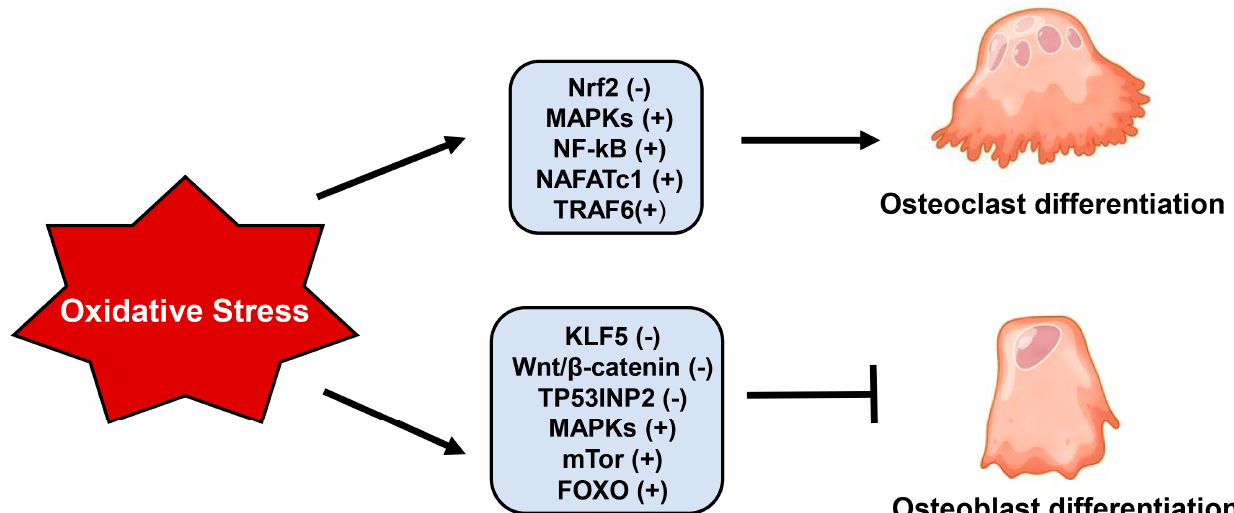
Figure 1. Principal molecular factors involved in the role of oxidative stress on osteoclastic and osteoblastic differentiation. Abbreviations: Nrf2, nuclear factor erythroid-2 related factor; MAPKs, mitogen-activated protein kinases; NF-kB, nuclear factor kappa B; NAFATc1, nuclear factor of activated T-cell cytoplasmic 1; TRAF-6, TNF receptor associated factor 6; KLF5, Krüppel-like factor 5; TP53INP2, tumor protein p53-inducible nuclear protein 2; mTor, mammalian target of rapamycin; FOXO, forkead proteins; ( − ) downregulated; (+) upregulated.